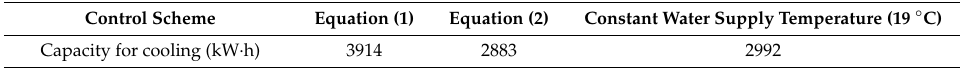
Table 7. Total cooling capacities of embedded tubes under various water temperature control